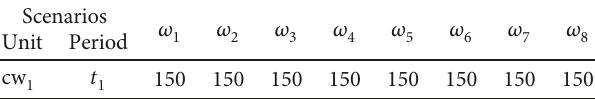
Table 4: Installed capacity for the candidate clean energy MW